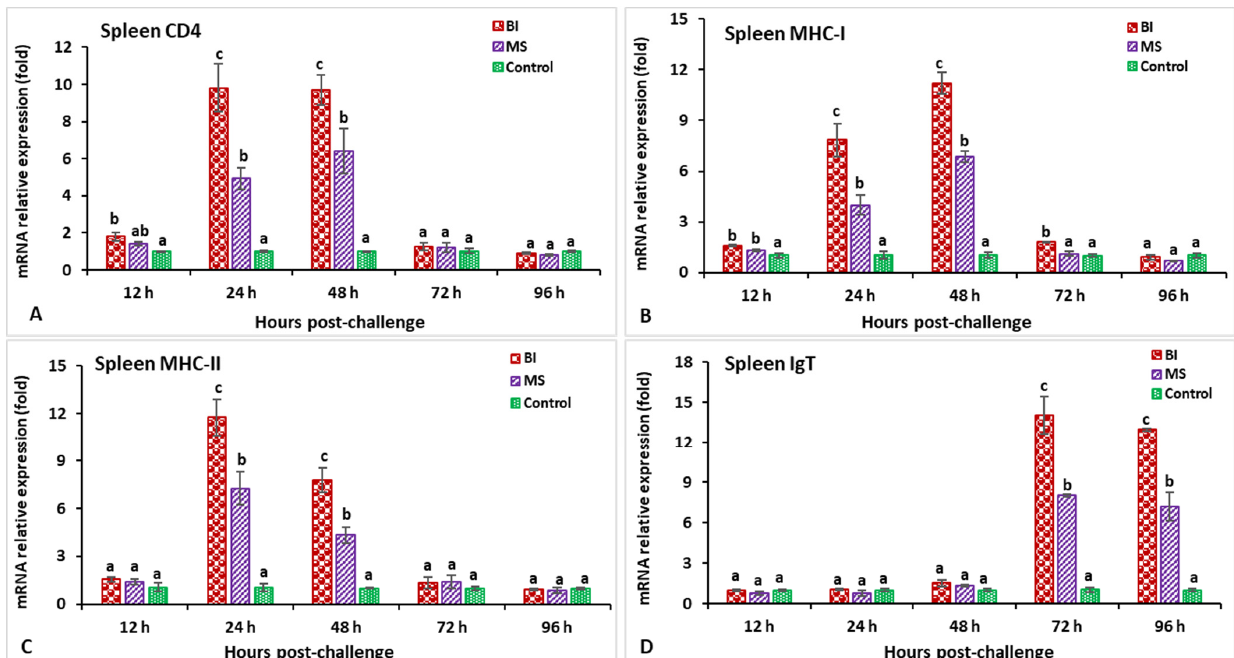
Figure 4. The gene expression of CD4 ( A ), MHC-I ( B ), MHC-II ( C ), and IgT ( D ) in the spleens of orally vaccinated fish after being challenged by Streptococcus iniae (mean ± SE, n = 3). Dissimilar letters denote significant differences ( p < 0.05).